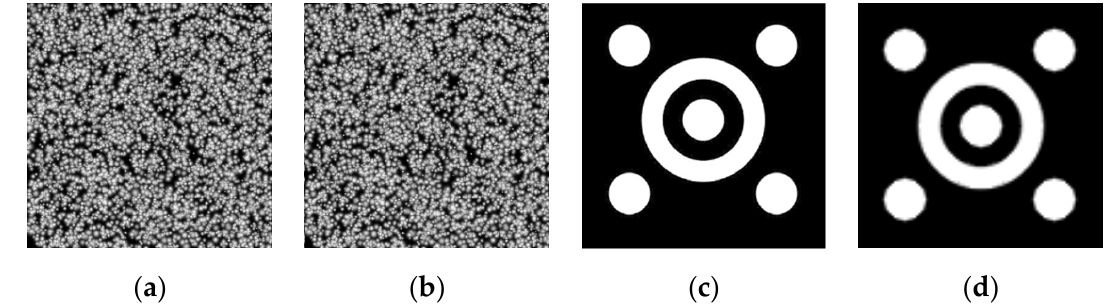
Figure 5. Target map for simulation experiment; ( a ) Original picture of DIC simulation experiment;